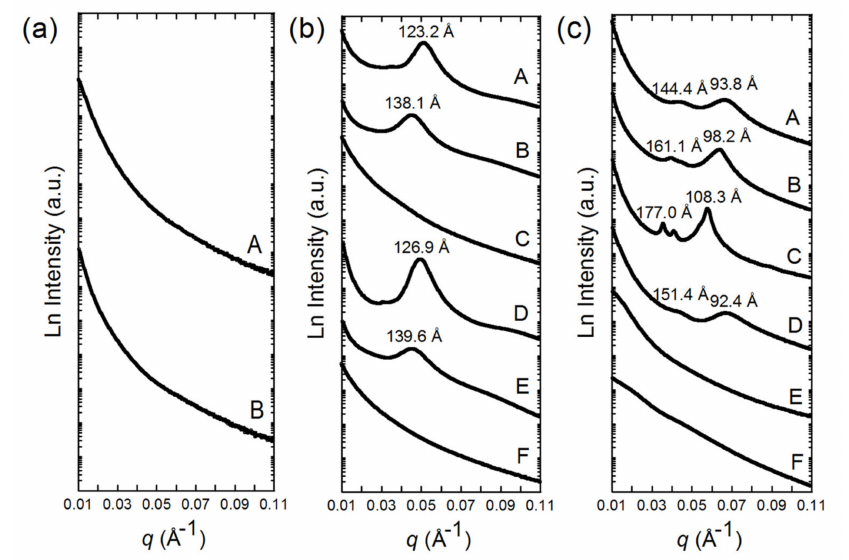
Figure 4. SAXS patterns of mesoporous silica samples: PMSF-1 ( a-A ), PMSF-2 ( a-B ), PMSA-1 ( b-A ), PMSA-2 ( b-B ), PMSA-3 ( b-C ), PMSA-4 ( b-D ), PMSA-5 ( b-E ), PMSA-6 ( b-F ), PMSB-1 ( c-A ), PMSB-2